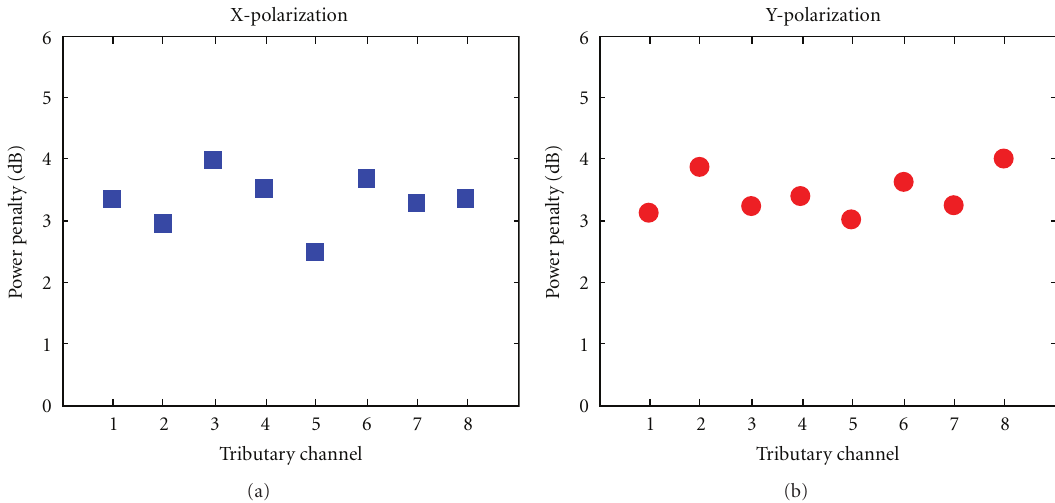
Figure 34: Power penalties of orthogonal tributary exchange for 8 tributary